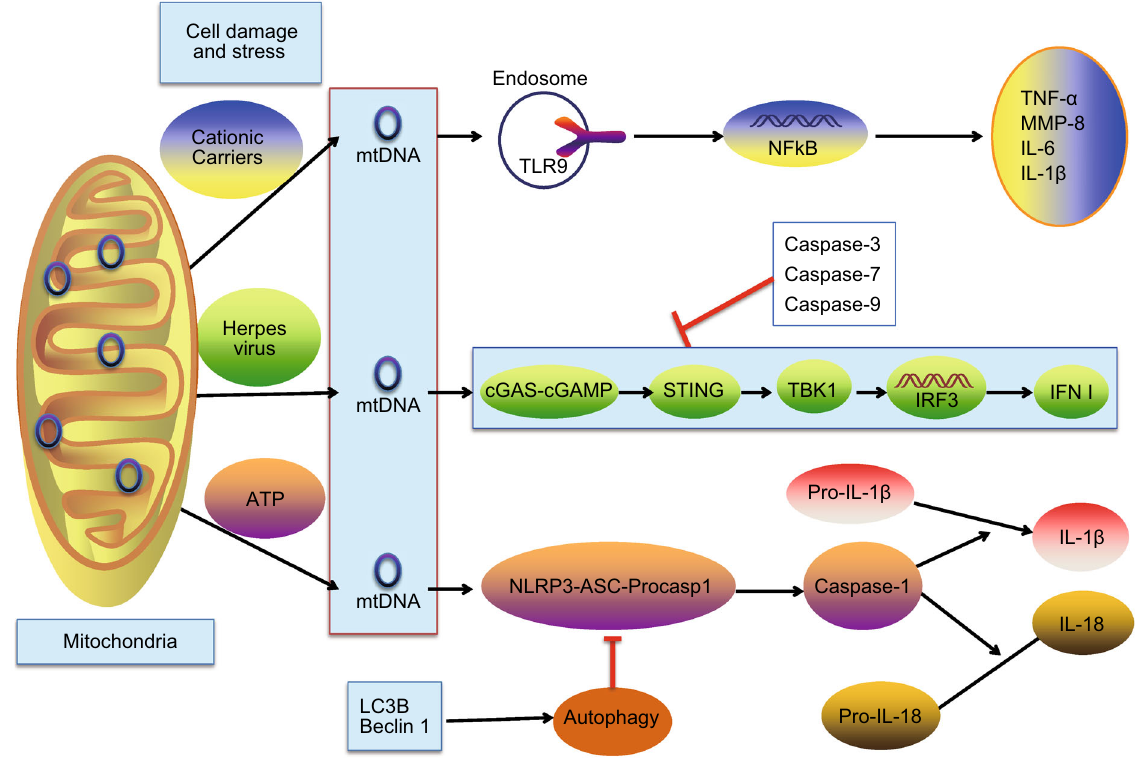
Figure 1. Mechanisms by which mitochondrial DNA activates innate immunity. Mitochondrial DNA (mtDNA) released from mitochondria following cell damage and stress (e.g. cationic carriers) can activate TLR9 in endosomes, leading to the transcription of pro-in fl ammatory cytokine genes and increased release of pro-in fl ammatory cytokines, including MMP-8, TNF- α , IL-6 and IL-1 β .